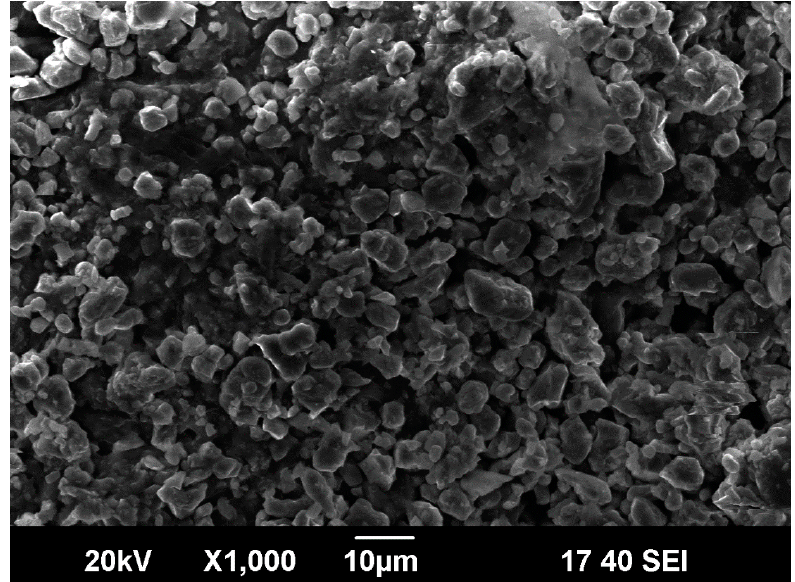
µ m-pore ceramic